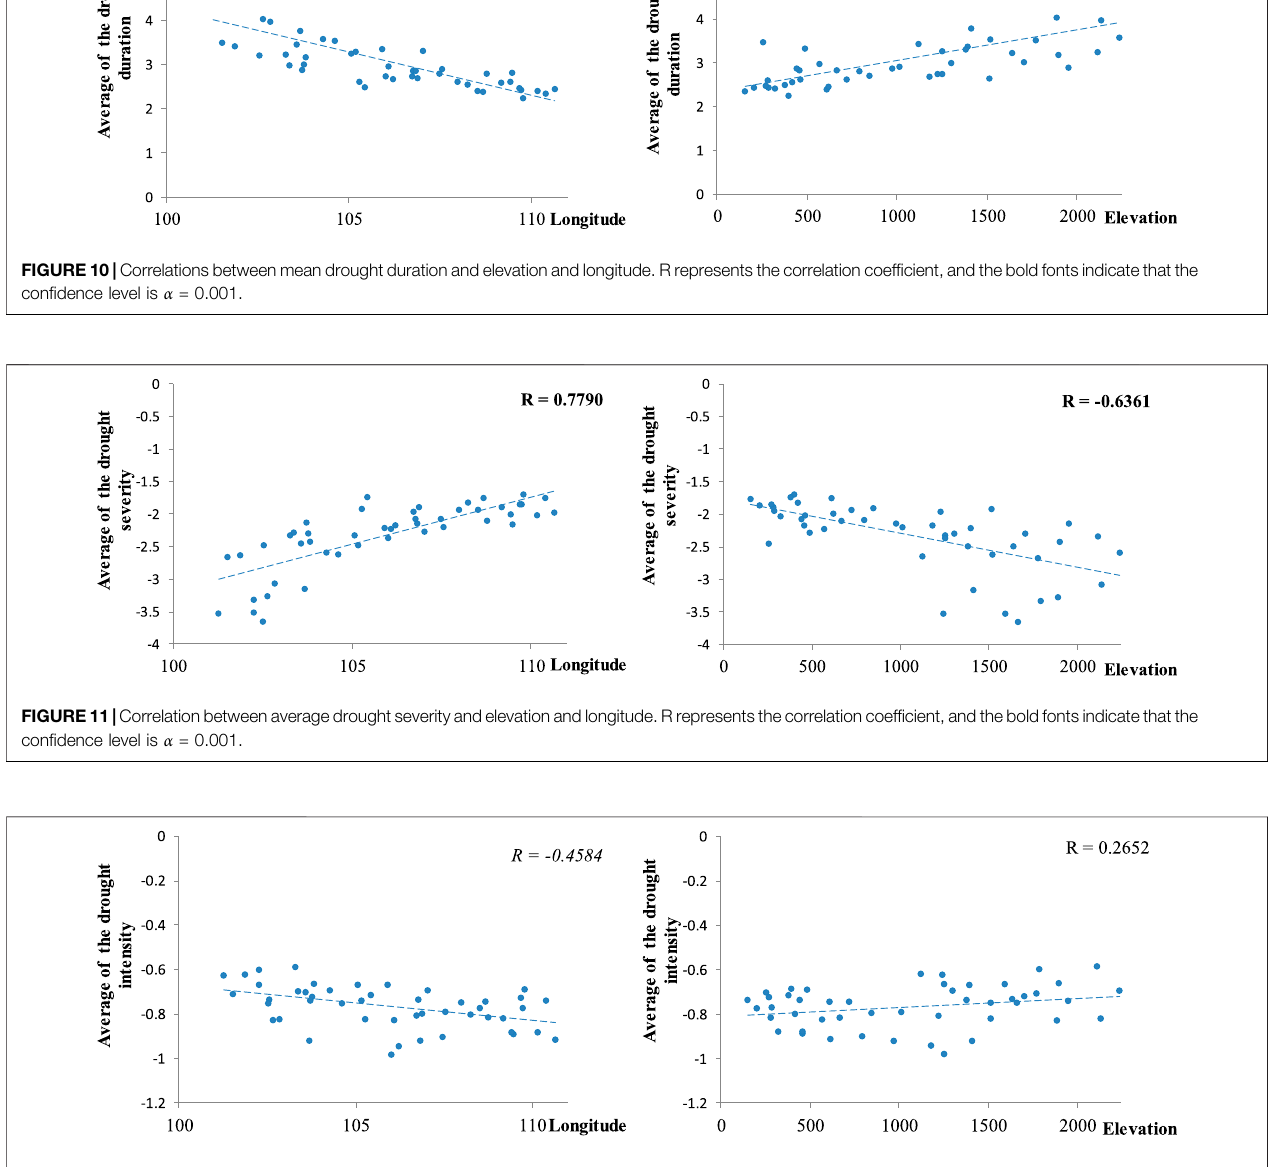
FIGURE12| Correlationbetweentheaveragedroughtintensityandtheelevationandlongitude.Rrepresentsthecorrelationcoef fi cient,andtheitalicsindicatethat the con fi dence level is α (cid:1) 0.01.